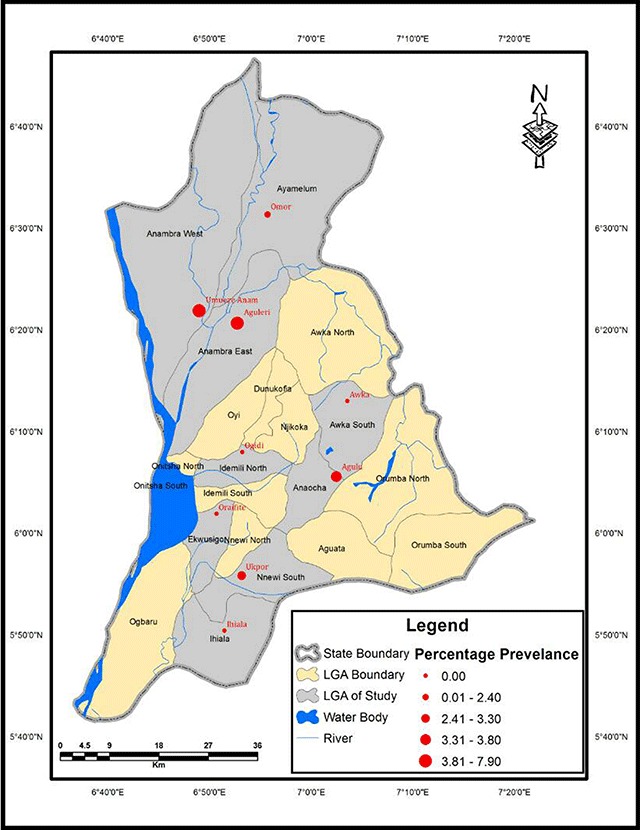
Prevalence map of urinary schistosomiasisbytowns in Anambra State, Nigeria.